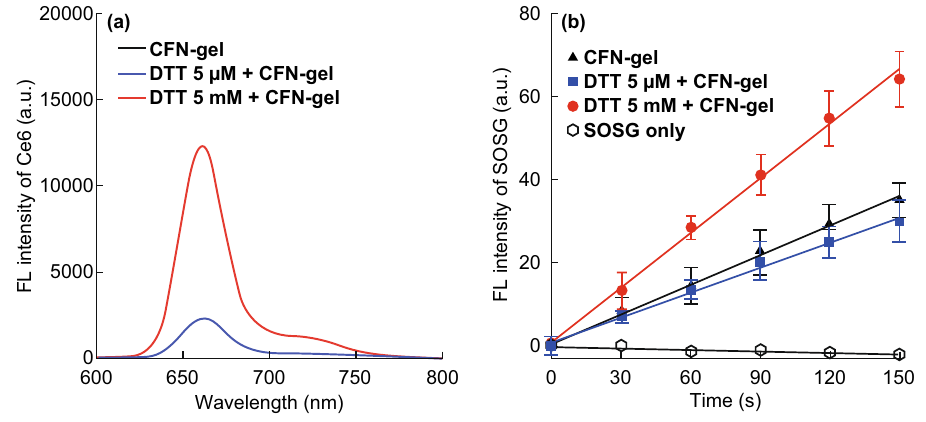
Fig. 3 Redox‑responsive turn‑on of fluorescence signal and singlet oxygen generation of CFN‑gel. a Fluorescence spectra of CFN‑gel treated with DTT (0, 5 µM or 5 mM) for 4 h ( λ ex = 400 nm), b time‑dependent increase in SOSG fluorescence of DTT‑treated CFN‑gel during 670‑nm laser irradiation ( n =